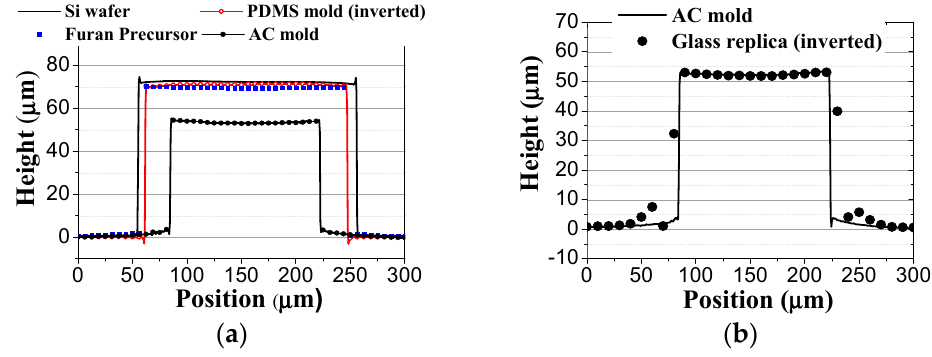
Figure 6. Comparison of cross-sectional surface profiles of the ( a ) silicon master, furan precursor, and AC mold; and ( b ) AC mold and replicated glass microfluidic structure. Table 1. Summary of the measured widths and heights of the microchannels for each fabrication step.